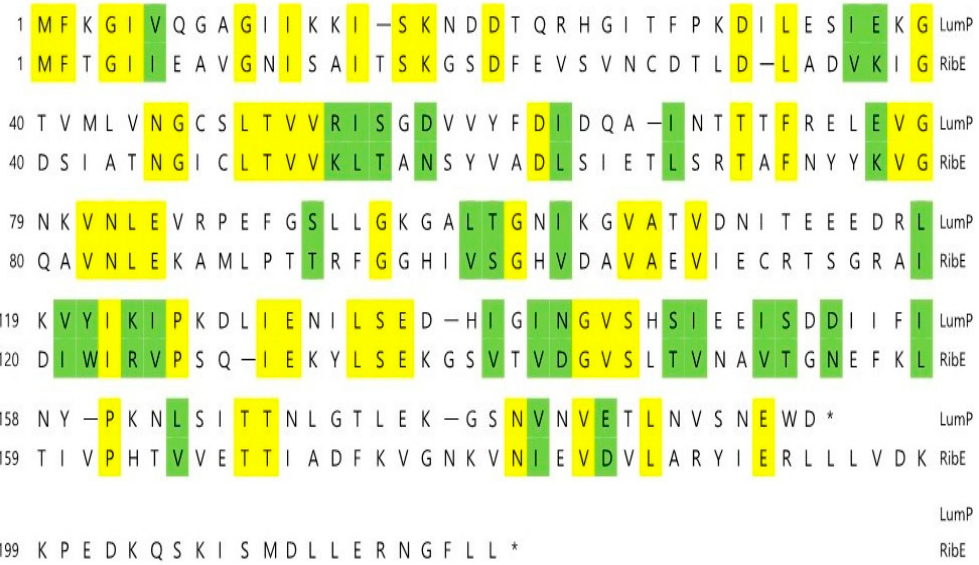
Figure 3. Comparison of amino acid sequences of lumazine protein (LumP) and riboflavin synthase (RibE) from Photobacterium phosphoreum. Identical or similar amino acids are shown boxed by yellow and green, respectively. Bars and asterisks indicate amino acid gaps and stop codons, respectively.